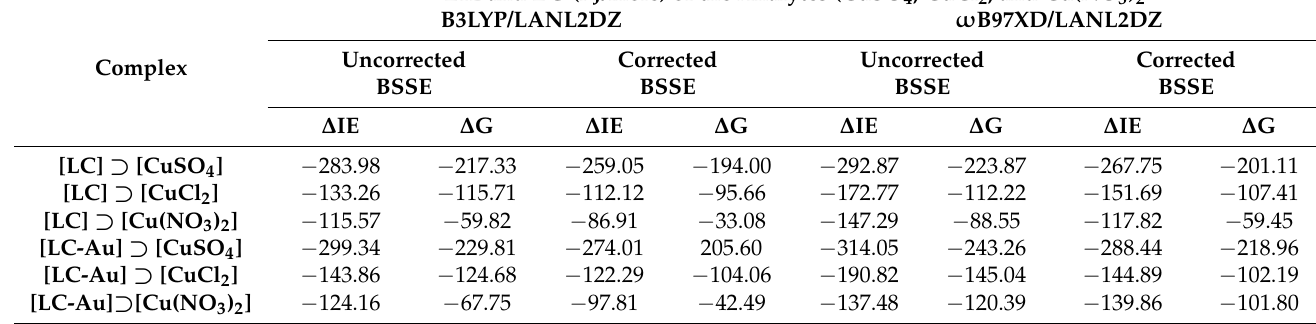
Table 3. Comparison of DFT-calculated electronic binding interaction energies ( ∆ IE kJ mol − 1 ) and Gibbs interaction energies ( ∆ G kJ mol − 1 ) in water solvent system for 1:1 complexes of LC, LC − gold (Au) with CuSO 4 , Cu(NO 3 ) 2 , and CuCl 2 at the B3LYP/LANL2DZ and ω B97XD/LANL2DZ levels of theory.